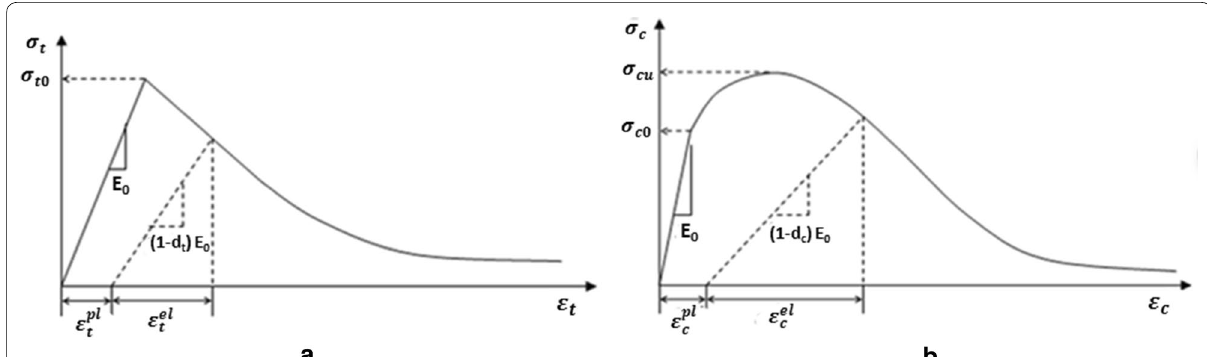
Fig. 8 Damage variables: a in tension, b in compression (Online Documentation Simulia 2016).